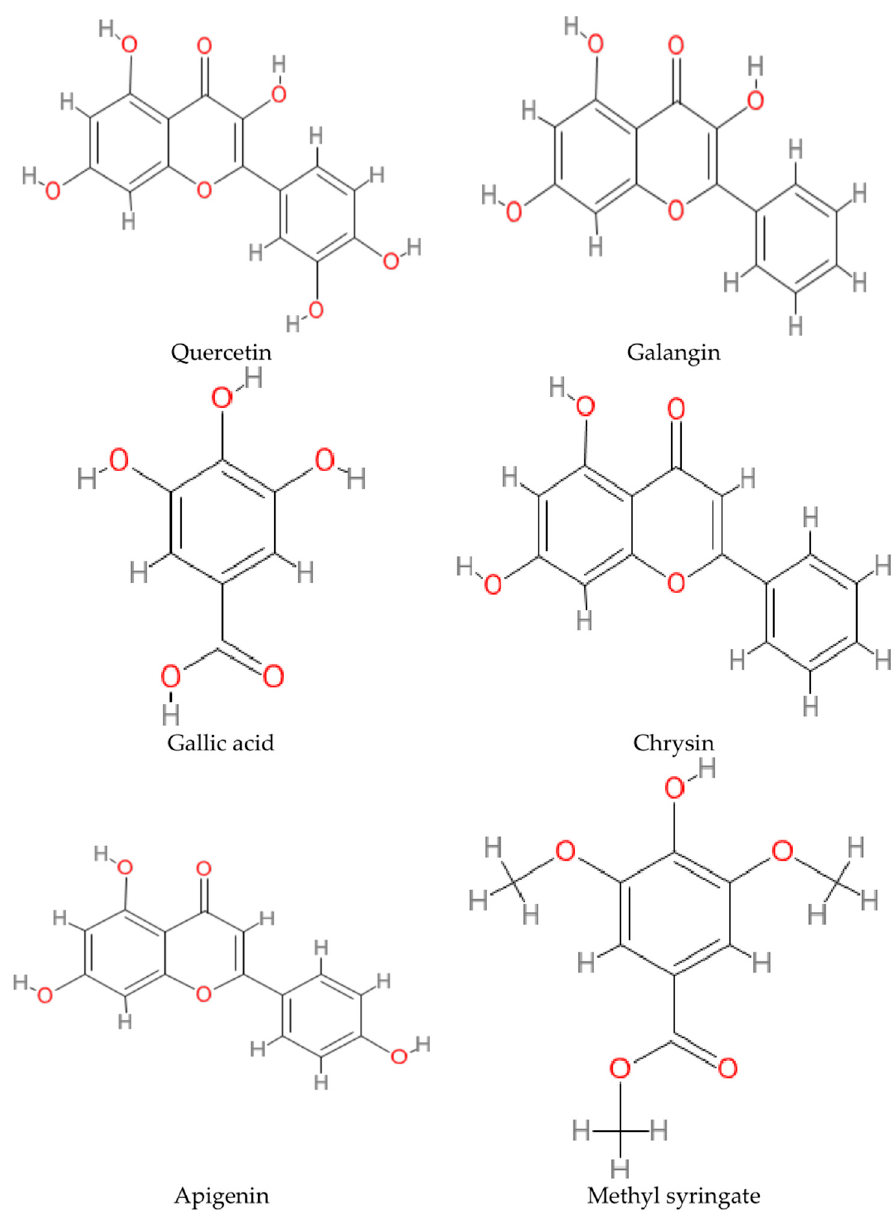
Figure 3. Chemical structures of the compounds from honey studied for anti-neurodegenerative properties.